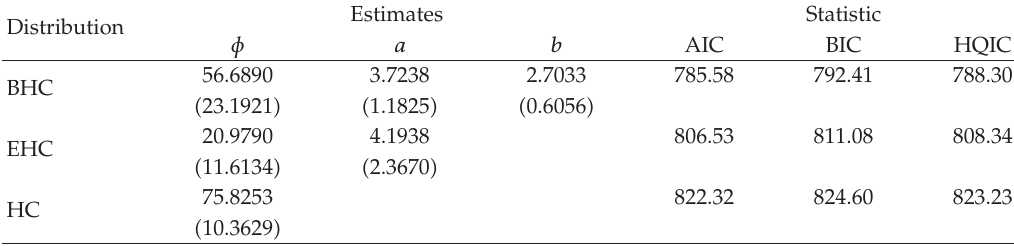
Table 1: MLEs (cid:2) standard errors in parentheses (cid:5) and the measures AIC, BIC, and HQIC. Estimates Statistic Distribution φ a